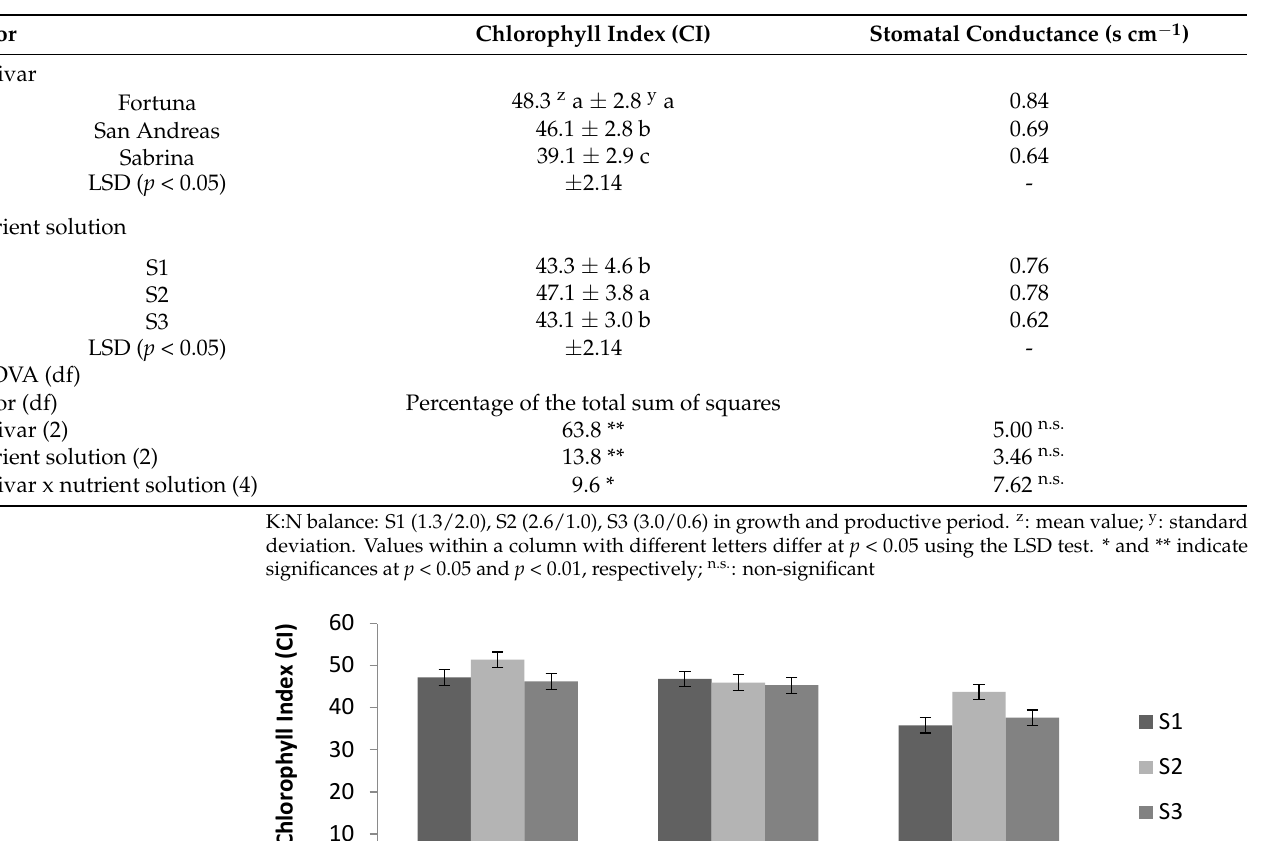
Table 2. Mean values, standard error ( ± ) and analysis of variance of chlorophyll index (CI) and stomatal conductance (s cm − 1 ) for three strawberry cultivars (Fortuna, San Andreas and Sabrina) irrigated with three nutrient solutions.